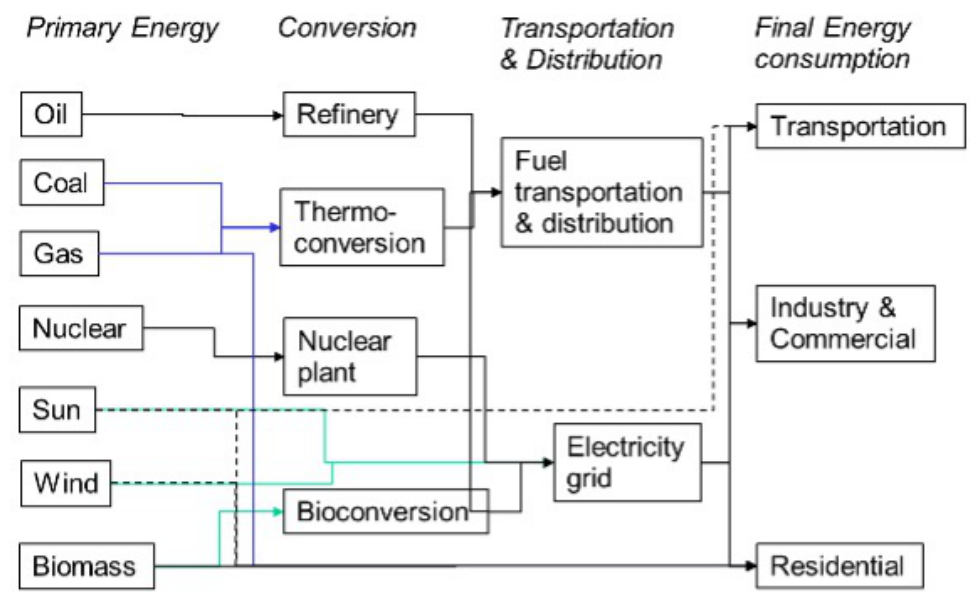
Figure 1. Illustration of energy supply system options (blue: gas, green: renewable: dotted: new connections).